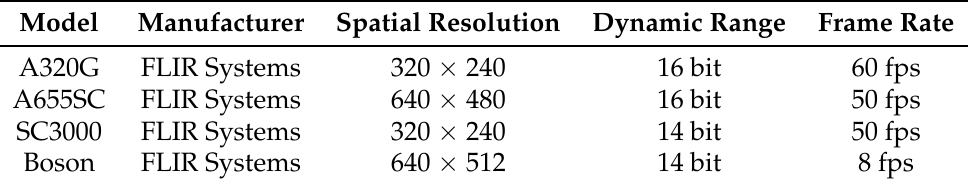
Table 1. Descriptions of